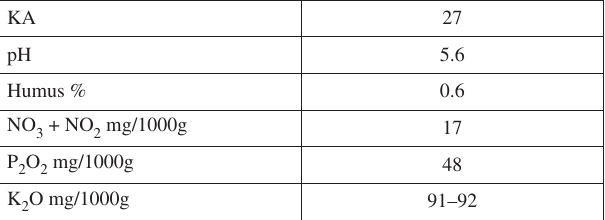
Table 2. Parameters of the soil of Pallag Experimental Station